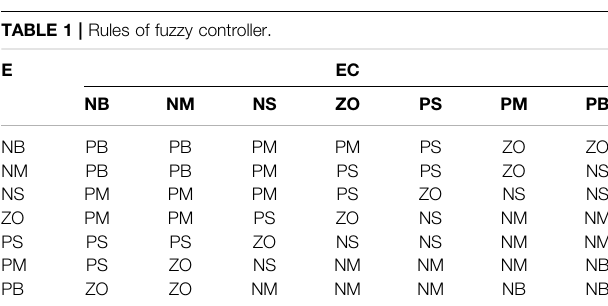
TABLE 1 | Rules of fuzzy